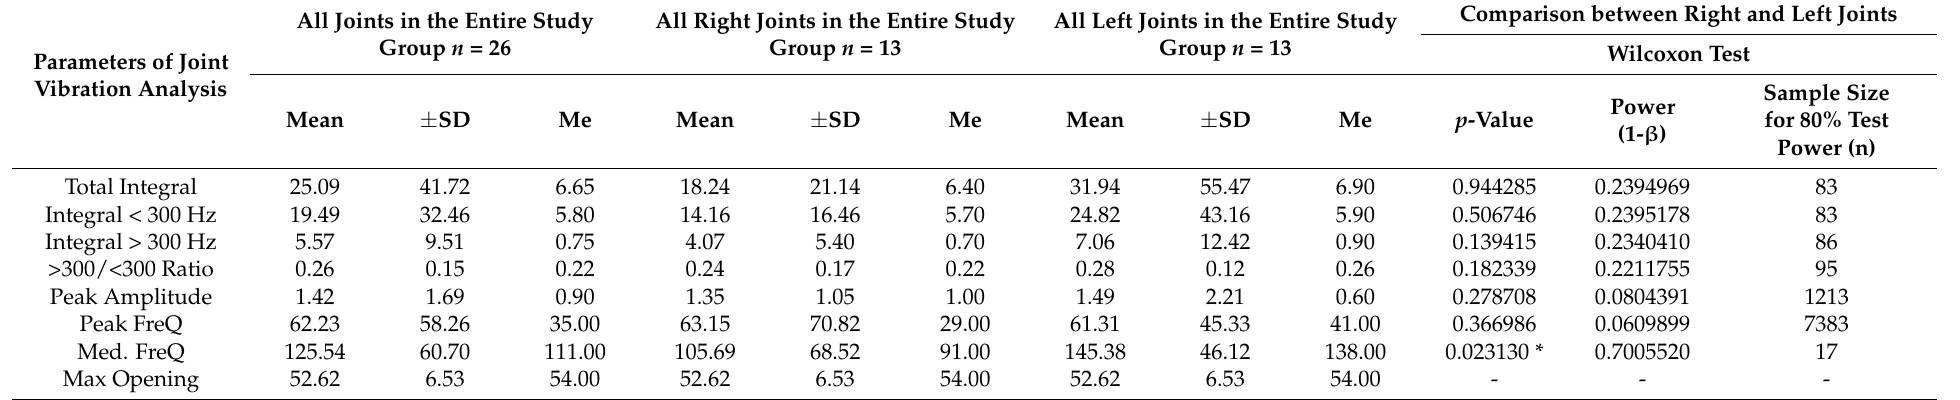
Table 5. Parameters of temporomandibular joint vibration analysis in the male group ( n = 13). The mean values, standard deviation ( ± SD), median (Me) and p -value are given.